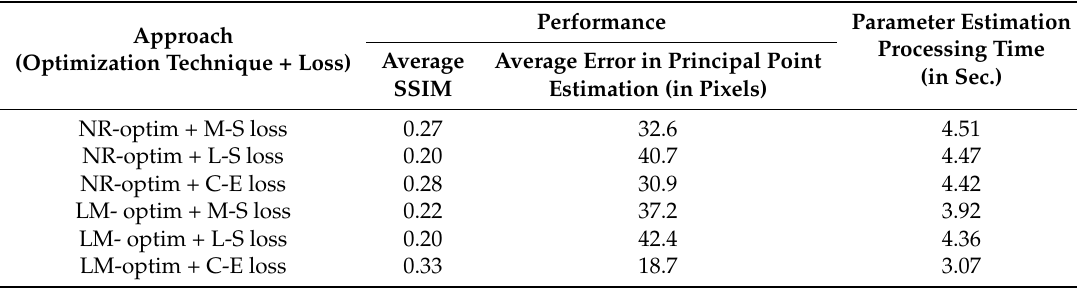
Synthetic data used in the ablation study validating the attributes of distortion parameter estimation. Table 1. Ablation study validating the attributes in proposed